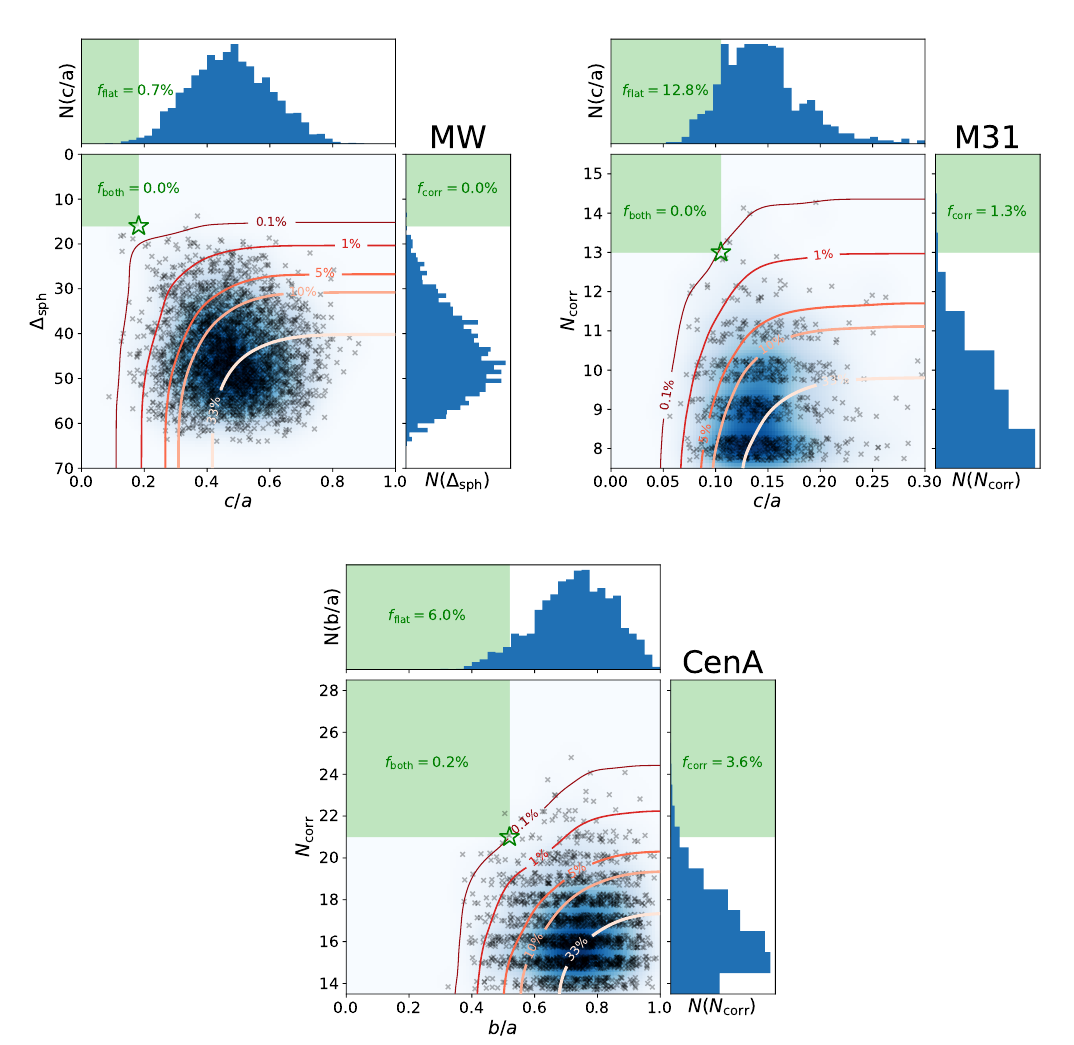
Figure 6. Comparison of flattening (horizontal axes) and kinematic coherence (vertical axes) of observed (green stars) satellite galaxy systems and those found around hosts of similar mass in cosmological simulations. For the Milky Way ( top-left panel ), flattening is measured as the minor-to-major axis ratio c / a of the 11 brightest (classical) satellites, while the kinematic coherence is measured using the spherical standard distance of the seven most-clustered orbital poles ∆ sph . The data are based on the analysis presented in Pawlowski and Kroupa [58], who report overall results to be very similar for other numbers of combined orbital poles, too. For Andromeda/M31 ( top-right panel ), the minor-to-major axis ratio flattening c / a of the 15 most-flattened out of 27 satellites within a mock PAndAS footprint is compared with the N corr number of satellites showing a coherent trend in the sign of their line-of-sight velocities relative to the host, as presented in Pawlowski & Sohn [ submitted ]. For CentaurusA ( bottom panel ), only the on-sky minor-to-major axis ratio b / a is used to determine the flattening of the observed system (to ensure independence of the more considerable distance uncertainties), while the kinematic coherence is quantified as in the case of Andromeda, with the number of satellites following a coherent line-of-sight velocity trend. This comparison is based on the analysis presented in Müller et al. [74]. All three comparisons are based on the same cosmological simulation, the highest-resolution, hydrodynamical Illustris TNG-100 run [88]. The blue shaded region indicates the density of individual satellite system realizations in the simulated analogs (grey crosses). The red contours indicate the fraction of systems lying to the top left of each point, i.e., the systems that are more flattened and more coherent in their velocities. The green-shaded areas delineate the regions where systems would be as or more extreme than the observed ones, and the fractions f indicate how many simulated systems fulfil these criteria. Clearly, none to only a few simulated systems are simultaneously as flattened and as kinematically coherent as the observed satellite planes. Only of order 0.1% of the simulated systems reproduce these two quantities of the observed satellite galaxy